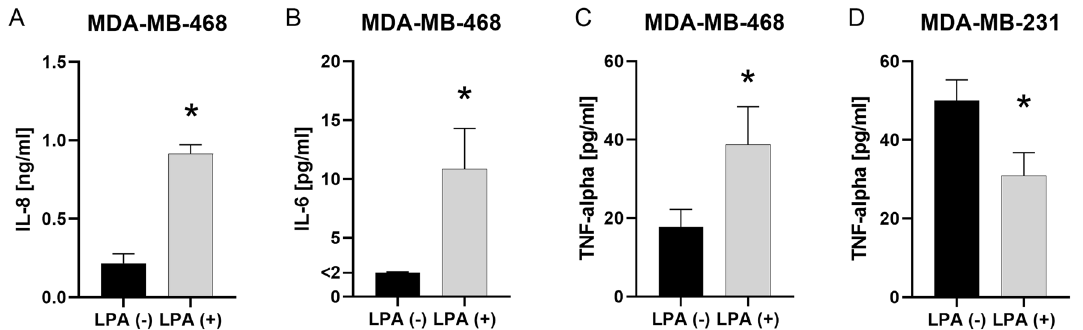
Figure 6. IL-8, IL-6 and TNF-alpha secretion after incubation with LPA. The secretion of IL-8, IL-6 and TNF- alpha of cell lines was measured with and without the addition of 1.0 μM lysophosphatidic acid (LPA) 18:1 using enzyme-linked immunosorbent assay (ELISA). (A–D) Columns show the concentration of (A) Interleukin 8 (IL-8), (B) Interleukin 6 (IL-6) and (C, D) tumor necrosis factor alpha (TNF-alpha) in the supernatant of (A–C) MDA-MB-468 and (D) MDA-MB-231 cells (y-axis) with and without the addition of LPA (x-axis). n = 3 replicate experiments. Values are presented as mean ± SD. *: p ≤ 0.05 (Mann–Whitney U